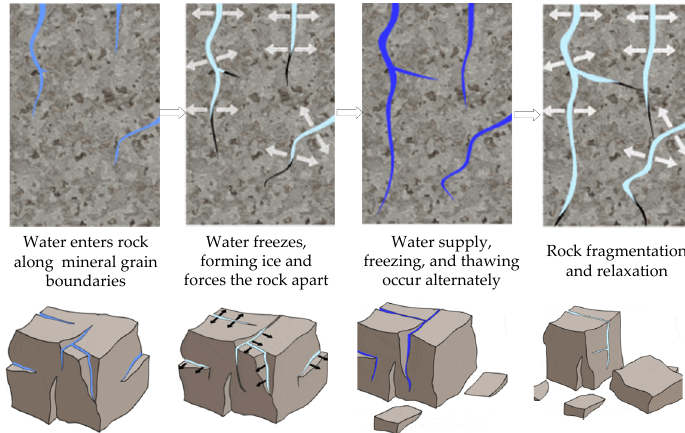
Figure 1. Freeze–thaw cracking process of fractured rock mass.